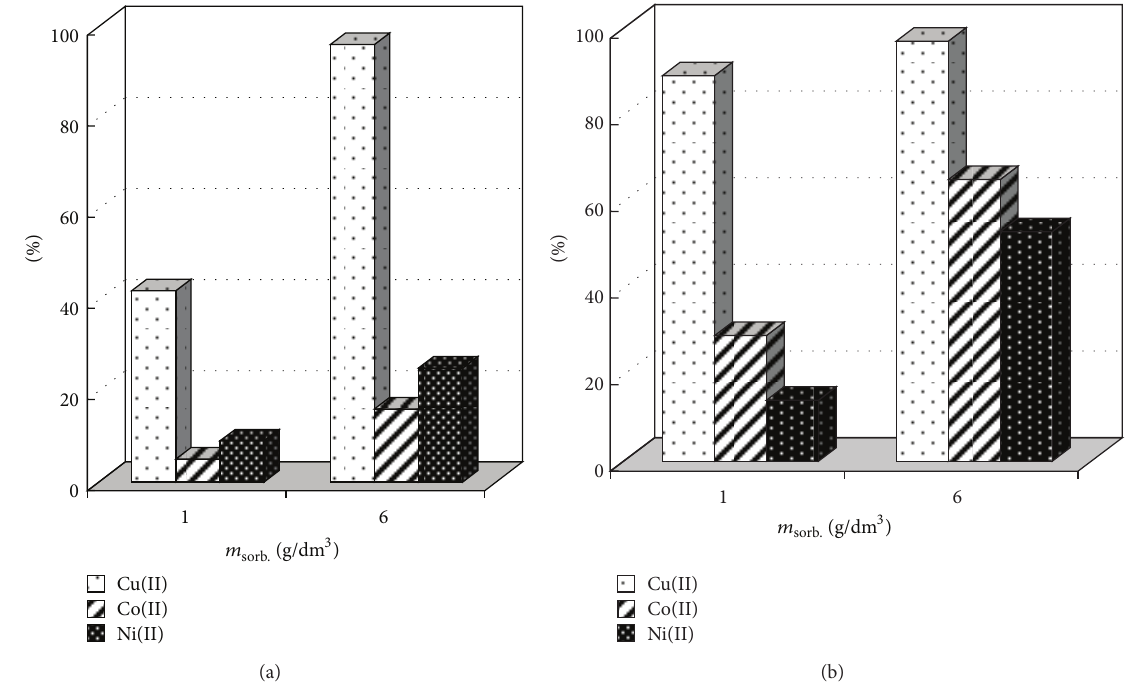
Figure 8: Influence of the dose of Zn,Al-CO 3 (a) and Zn,Al-EDTA (b) adsorbents on the degree of purification of aqueous solutions from Cu(II), Ni(II), or Co(II). 𝐼 = 0 ; pH 0 =